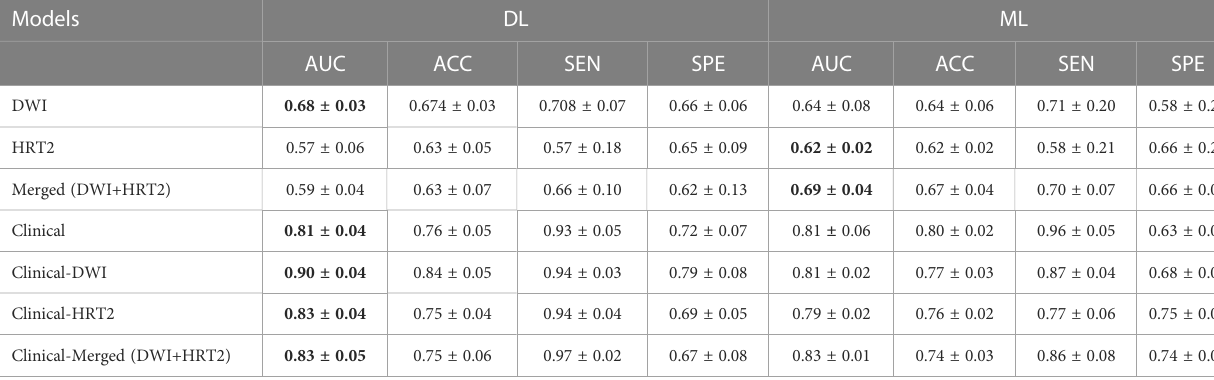
TABLE 3 Comparison of areas under the curve for all models. Models